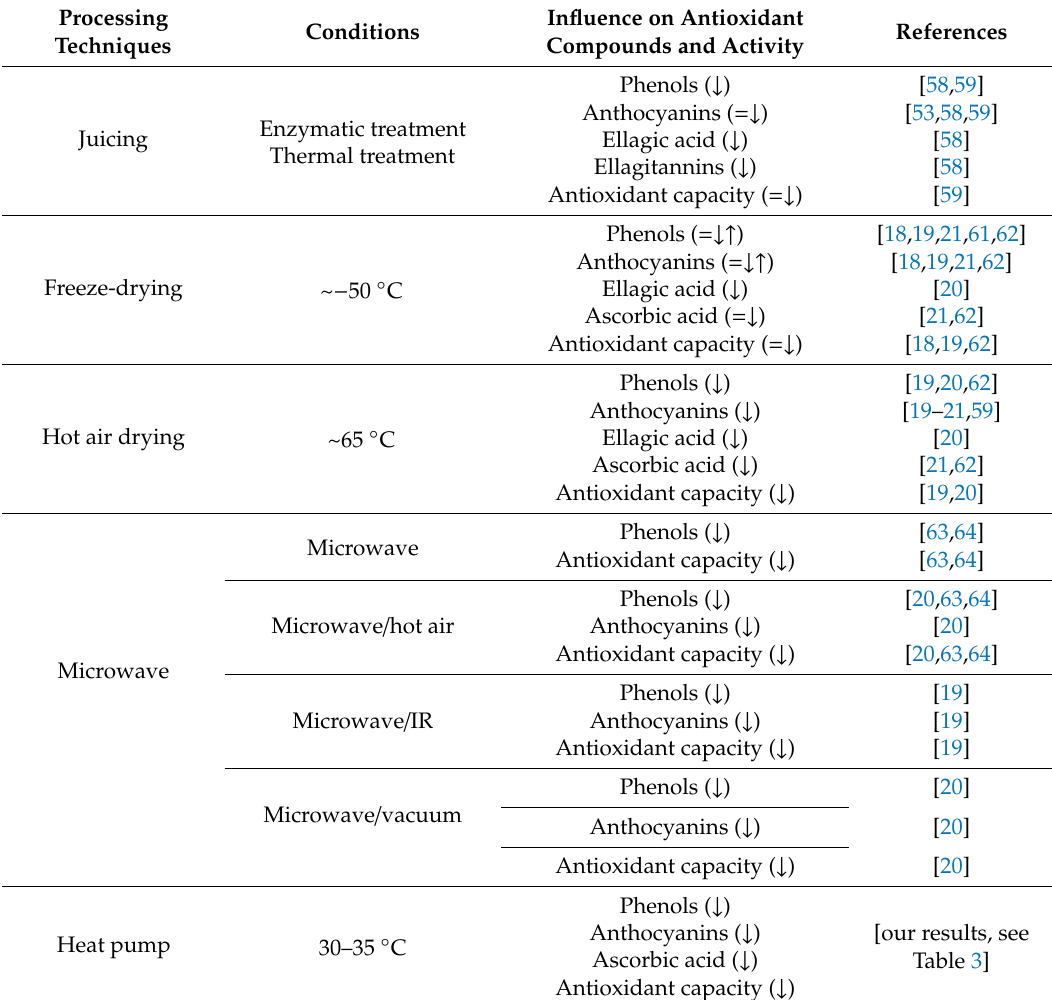
Table 2. Changes in content of selected bioactive compounds and antioxidant capacity by di ff erent processing techniques of fresh raspberry fruit. ( ↑ ): increased content; ( ↓ ): decreased content; ( = ): unchanged content.